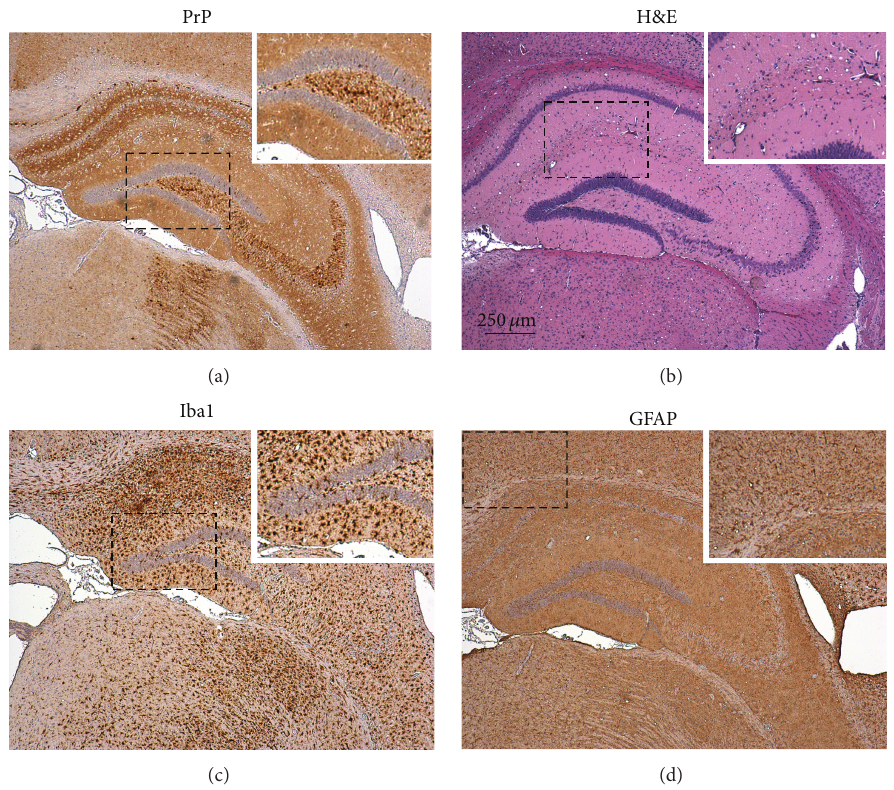
Figure 1: Neuropathological characteristics of prion disease within the brains of clinically affected mice. (a) Prion diseases are characterized by the presence of aggregations of abnormally folded, disease-specific prion protein (PrP) in affected tissues (brown). In the brain, as shown here, these accumulations are accompanied by extensive neuronal loss, spongiform change (indicated by vacuolation in panel “(b)”), reactive microglia (Iba1 + cells, panel “(c),” brown), and reactive astrocytes expressing high levels of glial fibrillary acidic protein (GFAP, panel “(d),” brown). Sections are counterstained with haematoxylin (blue).